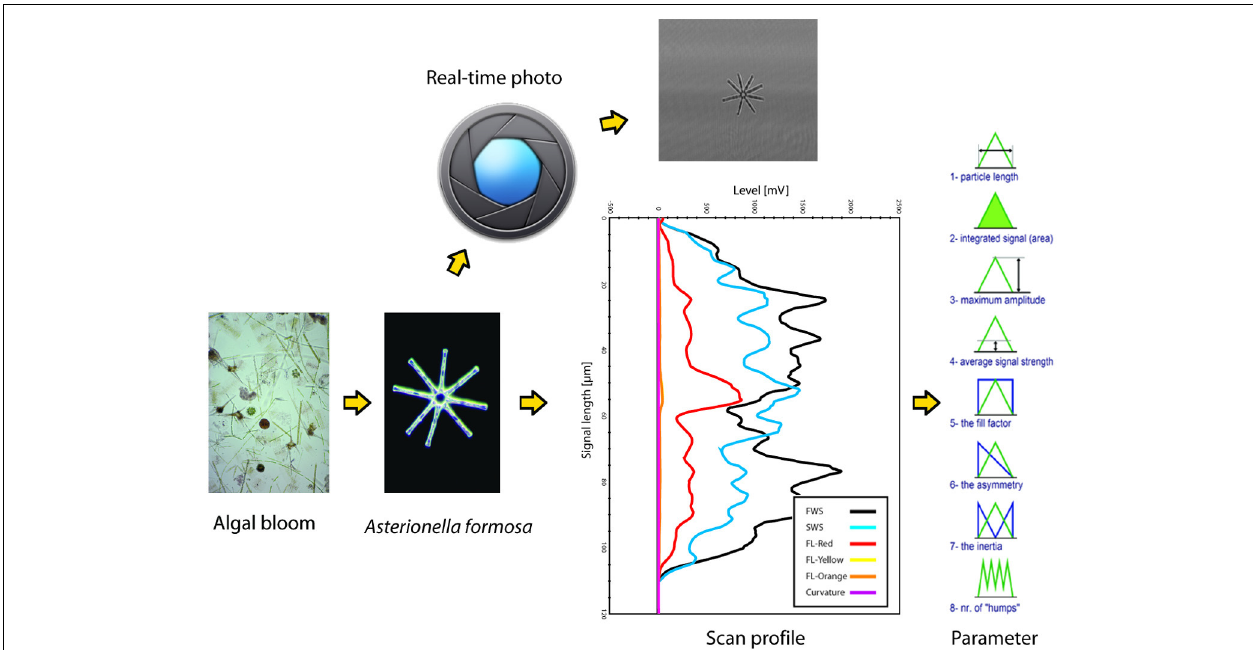
FIGURE 1 | Schematic summary of the scanning flow-cytometry approach to phytoplankton particle characterization, as operated by the Cytobuoy (Dubelaar et al., 1999; Dubelaar and Jonker, 2000). Particles in a water sample are separated by the instrument’s injector and internal fluid systems (not depicted in the figure) and then scanned by one or more lasers. Signals from different detectors (FWS, forward scattering; SWS, sideward scattering; FL-red, chlorophyll-a fluorescence; FL-yellow and -orange, fluorescence from accessory or degraded